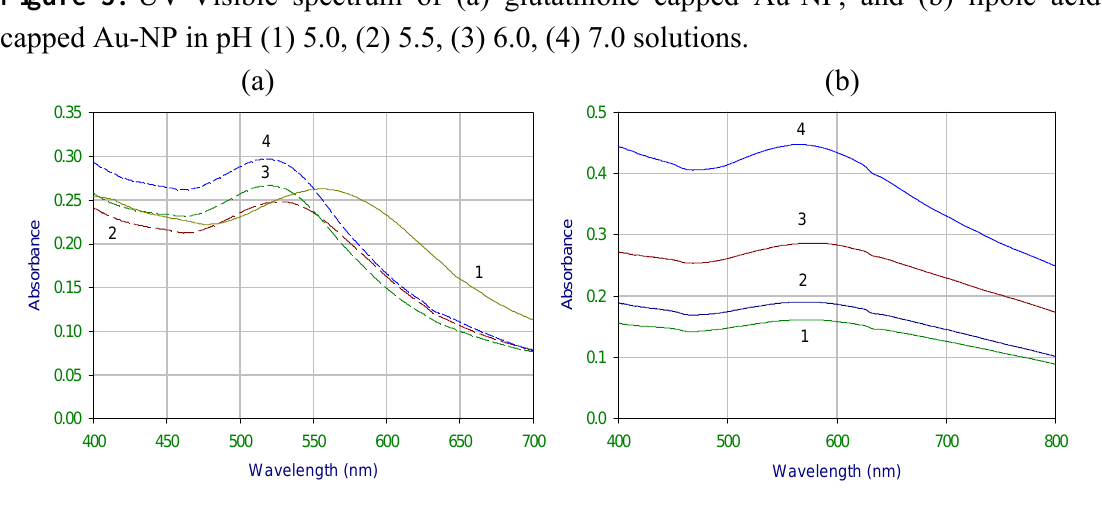
Figure 4e: 671 cm -1 and 518 cm -1 , probably S-S stretch) practically disappear (Figures 4c, 4f). Characteristic frequencies for the peptide bond are not significantly affected (Figure 4b: 3,128 cm -1 and 3,032 cm -1 ; Figure 4c: 3,271 cm -1 ; Figure 4e: 1,657 cm -1 and 1,541 cm -1 ; Figure 5f: 1,666 cm -1